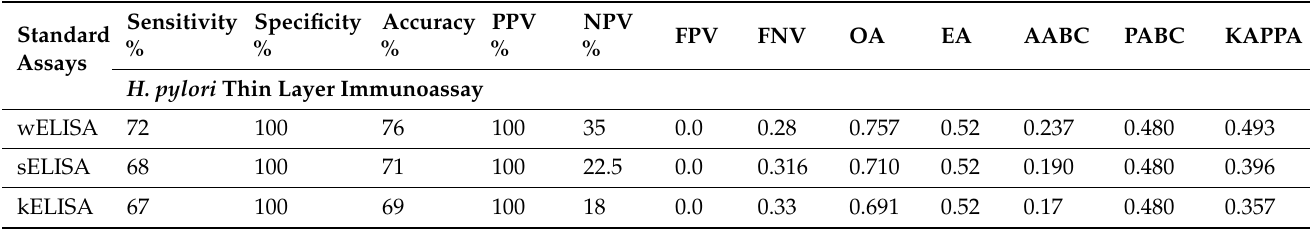
Table 1. Table showing comparative analysis of thin layer immunoassay with other comparable serological assays